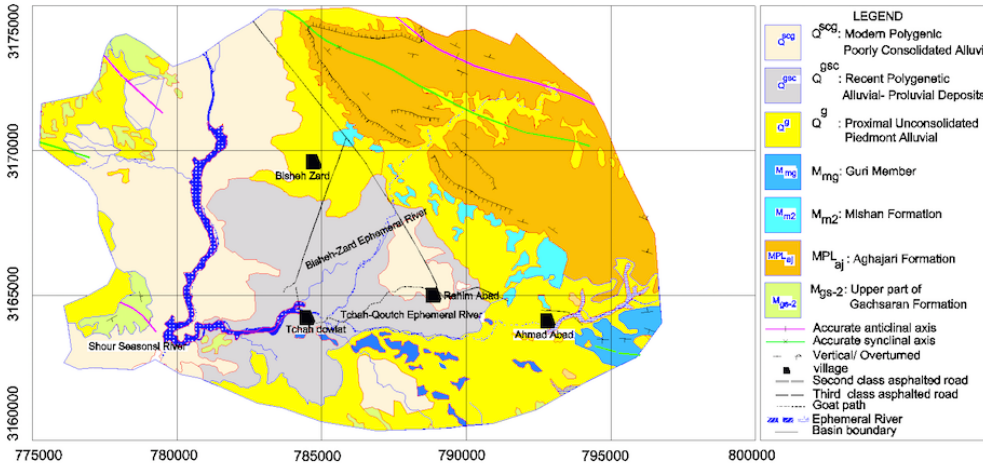
Figure 2. Geological map of the Gareh Bygone Plain and the upper basin (Bisheh Zard).